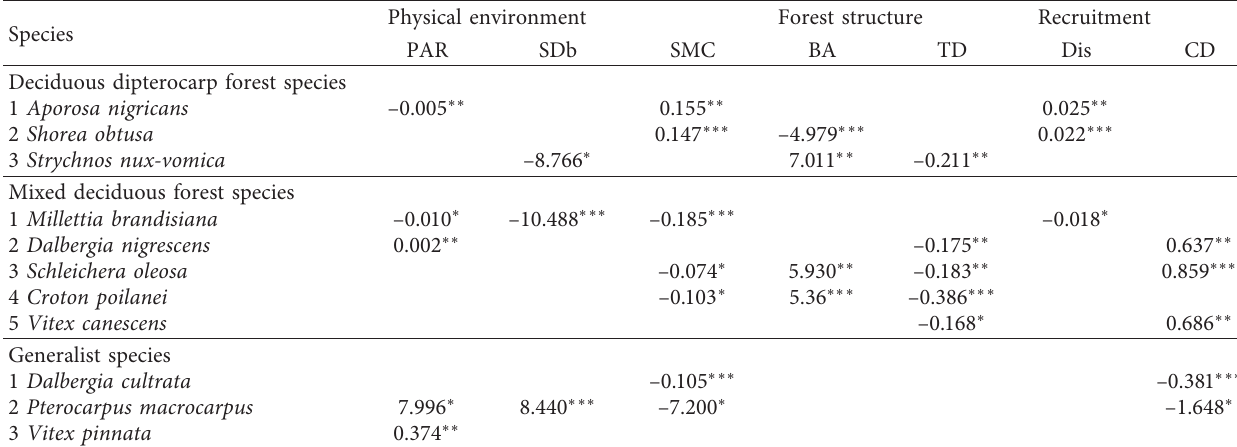
Figure 4: Nonmetric multidimensional scaling (NMS) ordination diagram of the distance from the edge to the forest interior (Dis, m), and the physical environmental variables (SMC, %; PAR, μ mol photons m − 2 s − 1 ; SDb, g cm − 3 ) affecting the distribution of woody tree species (DDF species (D), MDF species (M), and generalist species (G)) along the edge-interior gradients of different forest types (DDF and MDF) in the Mae Khum Mee subwatershed, Phrae Province. Table 5: Significant factors in the generalized linear mixed models of species with ≥ 30 stems, selected to minimize Akaike’s information criterion. The variables included physical environmental factors (photosynthetically active radiation (PAR, μ mol photons m − 2 s − 1 ) at 1.3m above the ground, soil moisture content (SMC, %), soil bulk density (SDb, g cm − 3 )), factors related to forest structure (basal area (BA, m 2 ha − 1 ), mature tree density (TD, stem ha − 1 )), and recruitment factors (distance from the edge to the forest interior (Dis, m), conspecific adult density (CD, stem 0.01 ha − 1